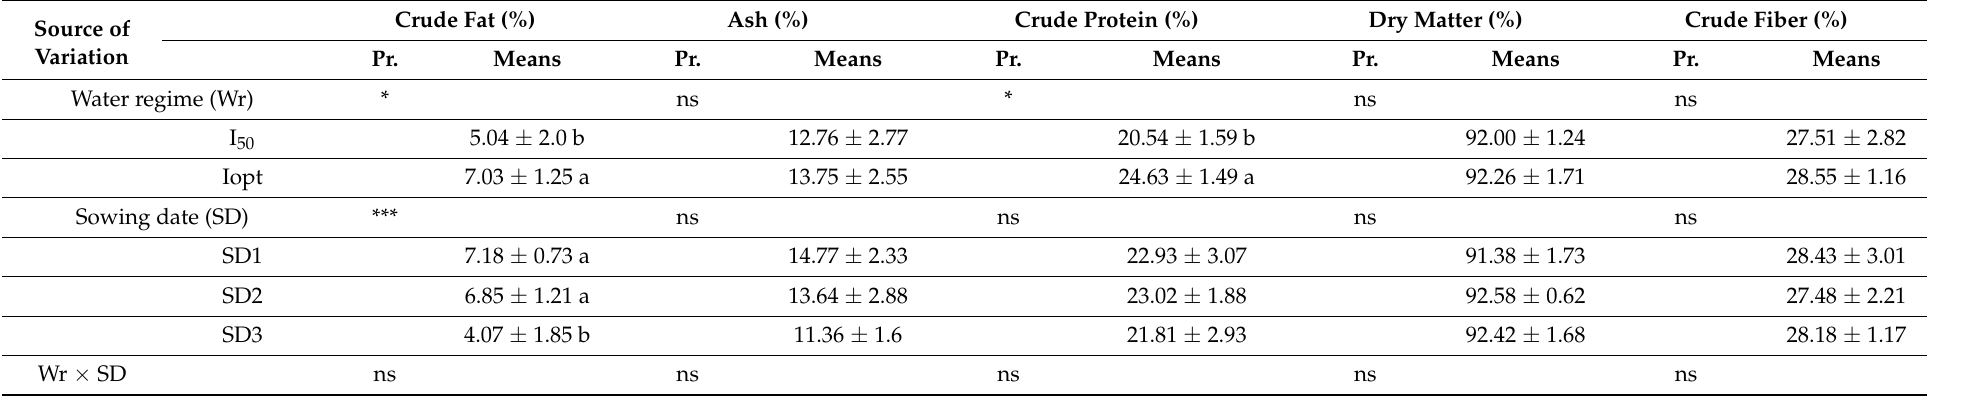
Table 5. The cannabis seed composition is affected by the water regime and sowing